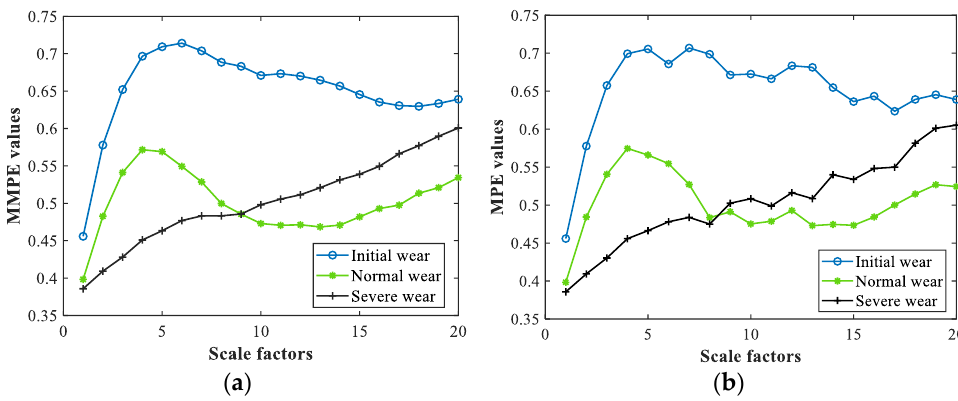
Figure 6. Entropy values denoting 3 different wear conditions. ( a ) MMPE and ( b ) MPE